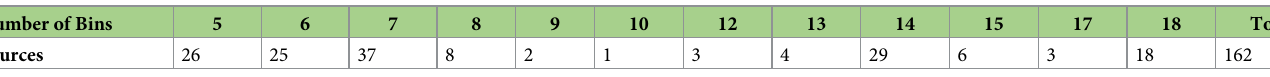
the standard duration method, we probabilistically split the bin into the proportion of individ- uals with each single year contained within the bin. Therefore, a bin containing individuals with at least one, but not more than four years of education, would be split into the proportion with one, two, three, and four years of attainment. This approach both allows for more nuanced estimation of average years of schooling, the study’s primary objective, and allows for the preservation of more precise information about the distribution of education within each population being measured. The first model uses nested hierarchical mixed effects, and the second uses a metric of space-time distance to determine an optimal training dataset before using a simple averaging process. Both models are run separately for each survey and sex specific five-year age group being split. In both cases, the first step is to take the binning schema present in the survey data being split and apply it to each single-year dataset in the training sample inducing the same bins. Next, one of the models delineated below is used to predict what proportion of each bin should be allocated to each single-year of attainment within that bin. Finally, the predicted proportions are normalized to ensure internal consistency for each bin. This step is necessary to adjust for the independent estimation of the proportion within each single year, guarantee- ing that the final estimates will add up to 100% of the bin of educational attainment being allo- cated. All code used to run the models is made available in the S2 File. Nested hierarchical mixed effects model. The first model uses the full set of all available training data, after the binning schema being split has been applied to each dataset, and a set of nested hierarchical mixed effects to capture the temporal and spatial trends in the distribution of proportions within each bin. The model is shown in Eq 2.